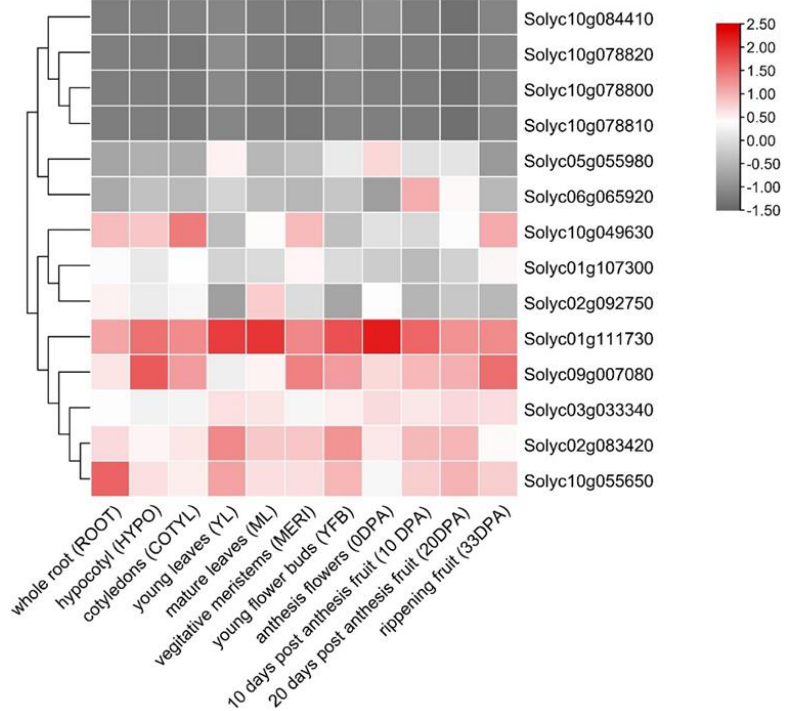
Figure 3. Expression profiles of tomato SlPP2C.D genes in various organs. Organ-specific expression of SlPP2C.D genes in tomato by using public RNA-sequencing data (The Tomato Genome Consortium, 2012). The values were log2 transformed with TBtools, and the cluster dendrogram conducted by rows is shown on the left of the heat map. Blocks with grey colors indicate decreased and red ones indicate increased transcription levels. Root, whole root; Hypo, hypocotyl; Cotyl, cotyledon; YL, young leaf; ML, mature leaf; MER, vegetative meristem; YFB, young flower bud; 0 DPA, flower at anthesis; 10 DPA, fruit at 10 DPA; 20 DPA, fruit at 20 DPA; 33 DPA, fruit at 33 DPA.